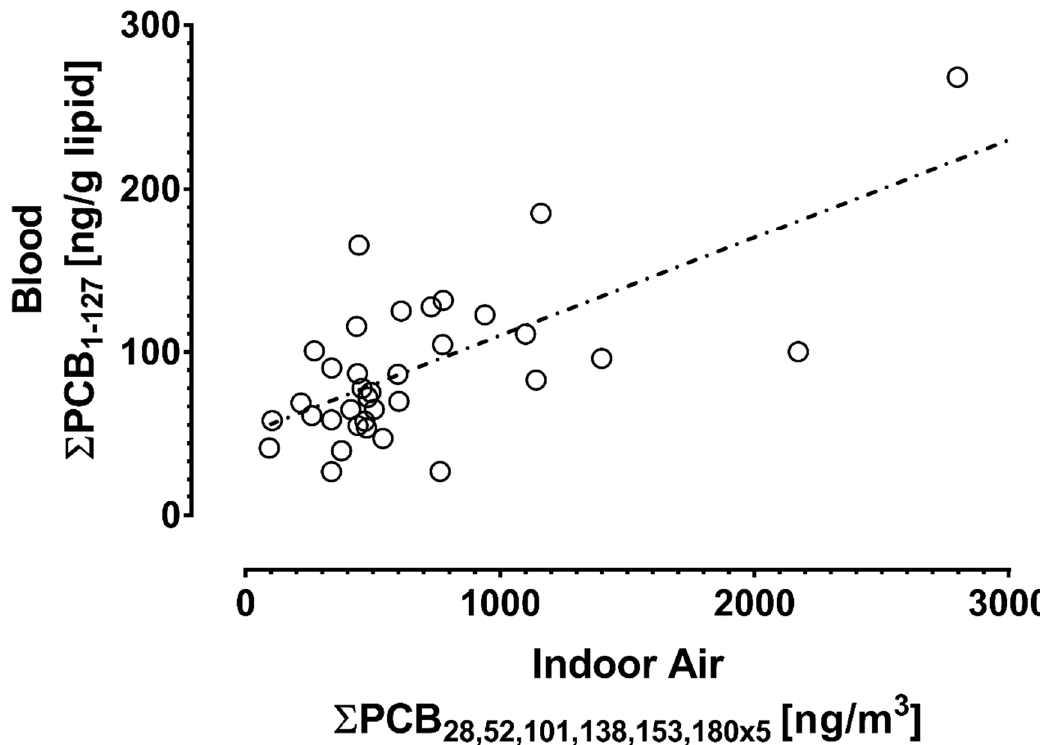
Figure 5. Relationship between PCBs in indoor air (ng/m 3 ) and PCBs in human blood lipids (ng/g l.w.) ( n = 35). The straight